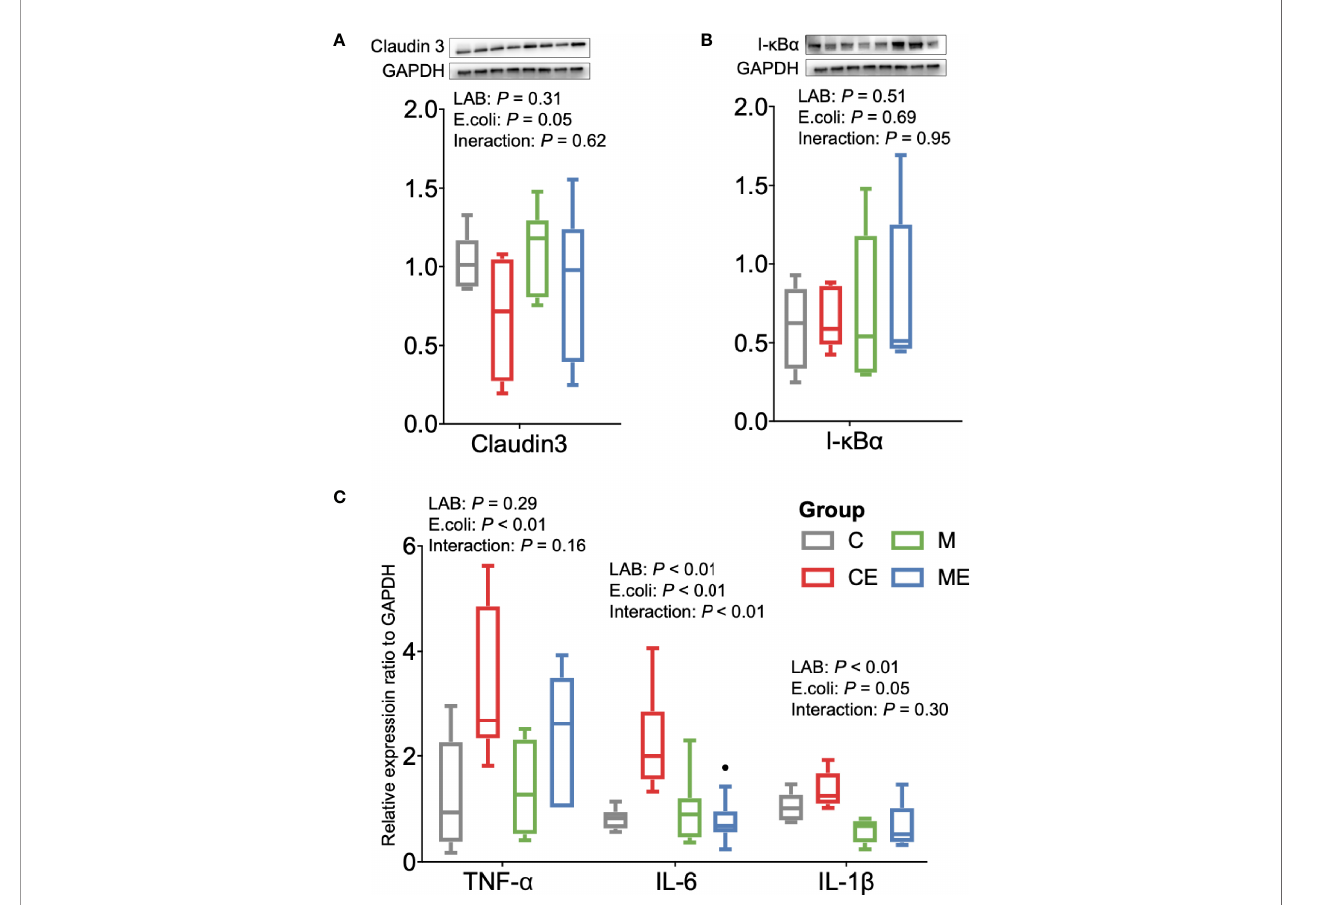
FIGURE 6 | In fl ammation status of the gut in control mice (C), control mice challenged with Escherichia coli (CE), mice fed mixed LAB strains (M), and mice fed mixed LAB strains and challenged with Escherichia coli (ME). Ratio of (A) Claudin3, (B) I- k B a , and (C) mRNA expression of cytokines in the gut of mice between four groups. GAPDH, glyceraldehyde-3-phosphate dehydrogenase; I- k B a , nuclear factor of kappa light polypeptide gene enhancer in B-cells inhibitor, alpha; TNF- a , tumor necrosis factor alpha; IL,